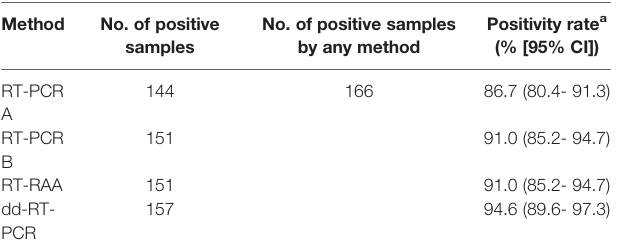
TABLE 5 | Performance characteristics of 4 methods in testing 197 saliva samples from 12